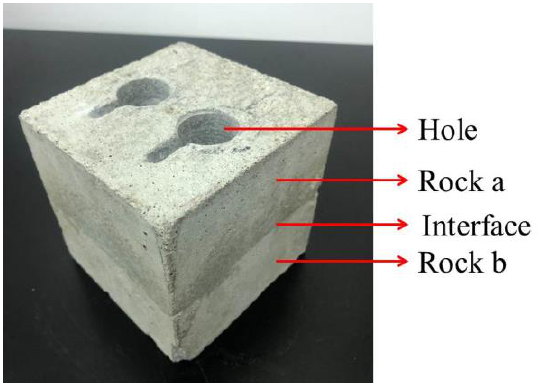
Figure 6. Schematic of borehole specimen.